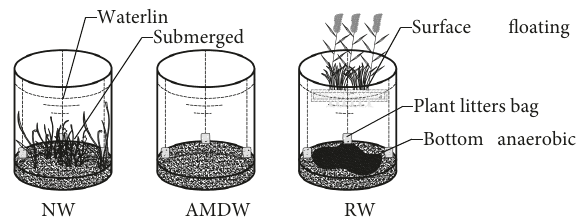
Figure 1: Microcosm experimental setup. NW: simulating the natural aquatic ecosystem; RW: simulating the eco-remediation AMD- contaminated aquatic ecosystem; AMDW: simulating the AMD-contaminated aquatic ecosystem. In the microcosm RW, an eco-re- mediation system that combines floating aerobic wetlands on the surface with constructed anaerobic sediments in the bottom (SFW-BAS) was